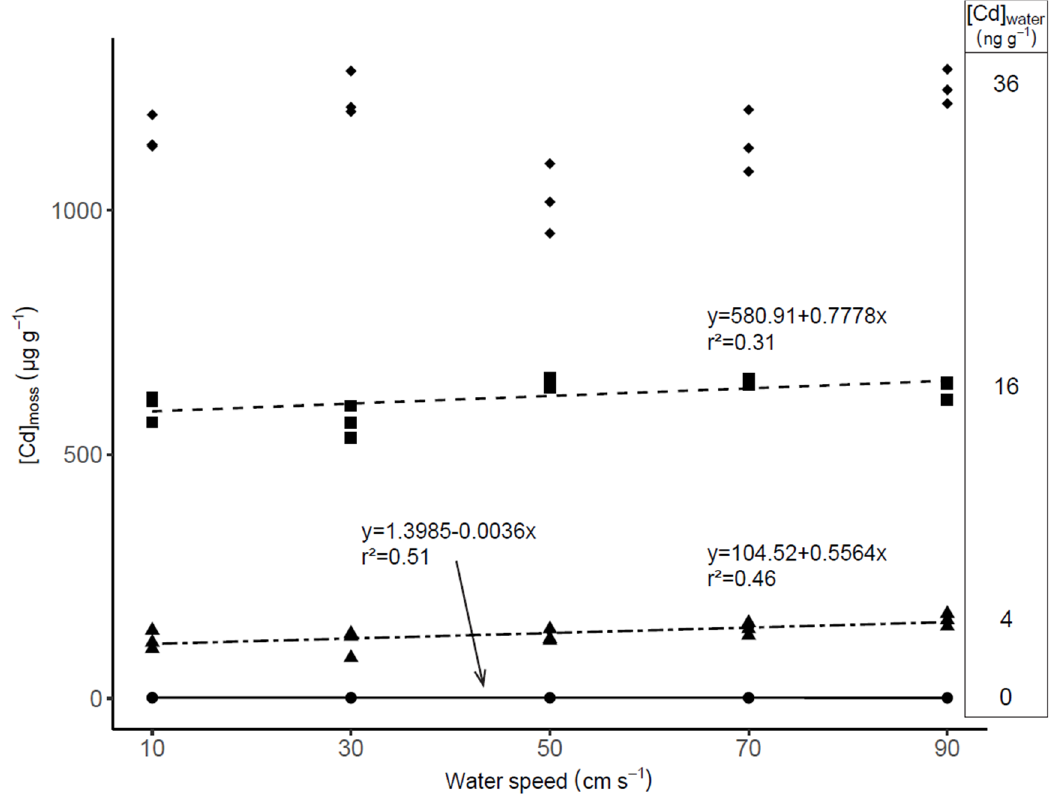
Figure 2. Correlation between the concentration of Cd in Fontinalis antipyretica transplants and water velocity depending on the concentration of Cd in the water. The best fit lines of the models for each group exposed to different concentrations are shown for 0, 4 and 16 ng g − 1 of Cd in water. For these models, both the intercepts and the slopes are significant ( p < 0.05). The model was not significant for the samples exposed to 36 ng g − 1 of Cd. The formula and the adjusted r 2 of each model are shown next to each best fit line. In the control (0 Cd) group, the variance was small, and the points for the 3 replicates overlap in the figure.